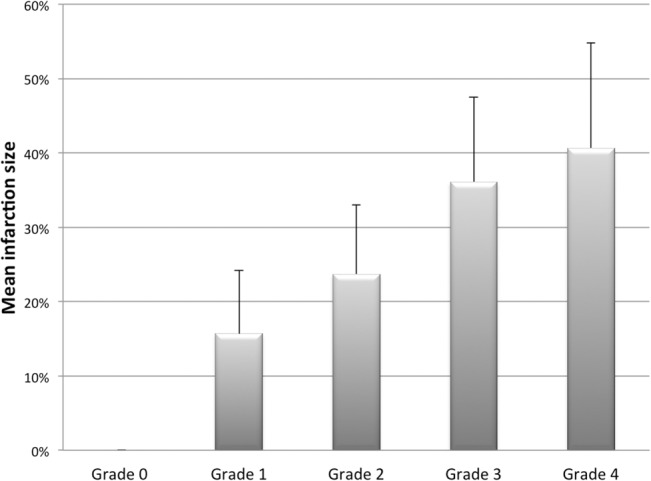
Infarction sizes (expressed as percentage of myocardial necrosis to left ventricular mass) increased remarkably in patients with higher grades.